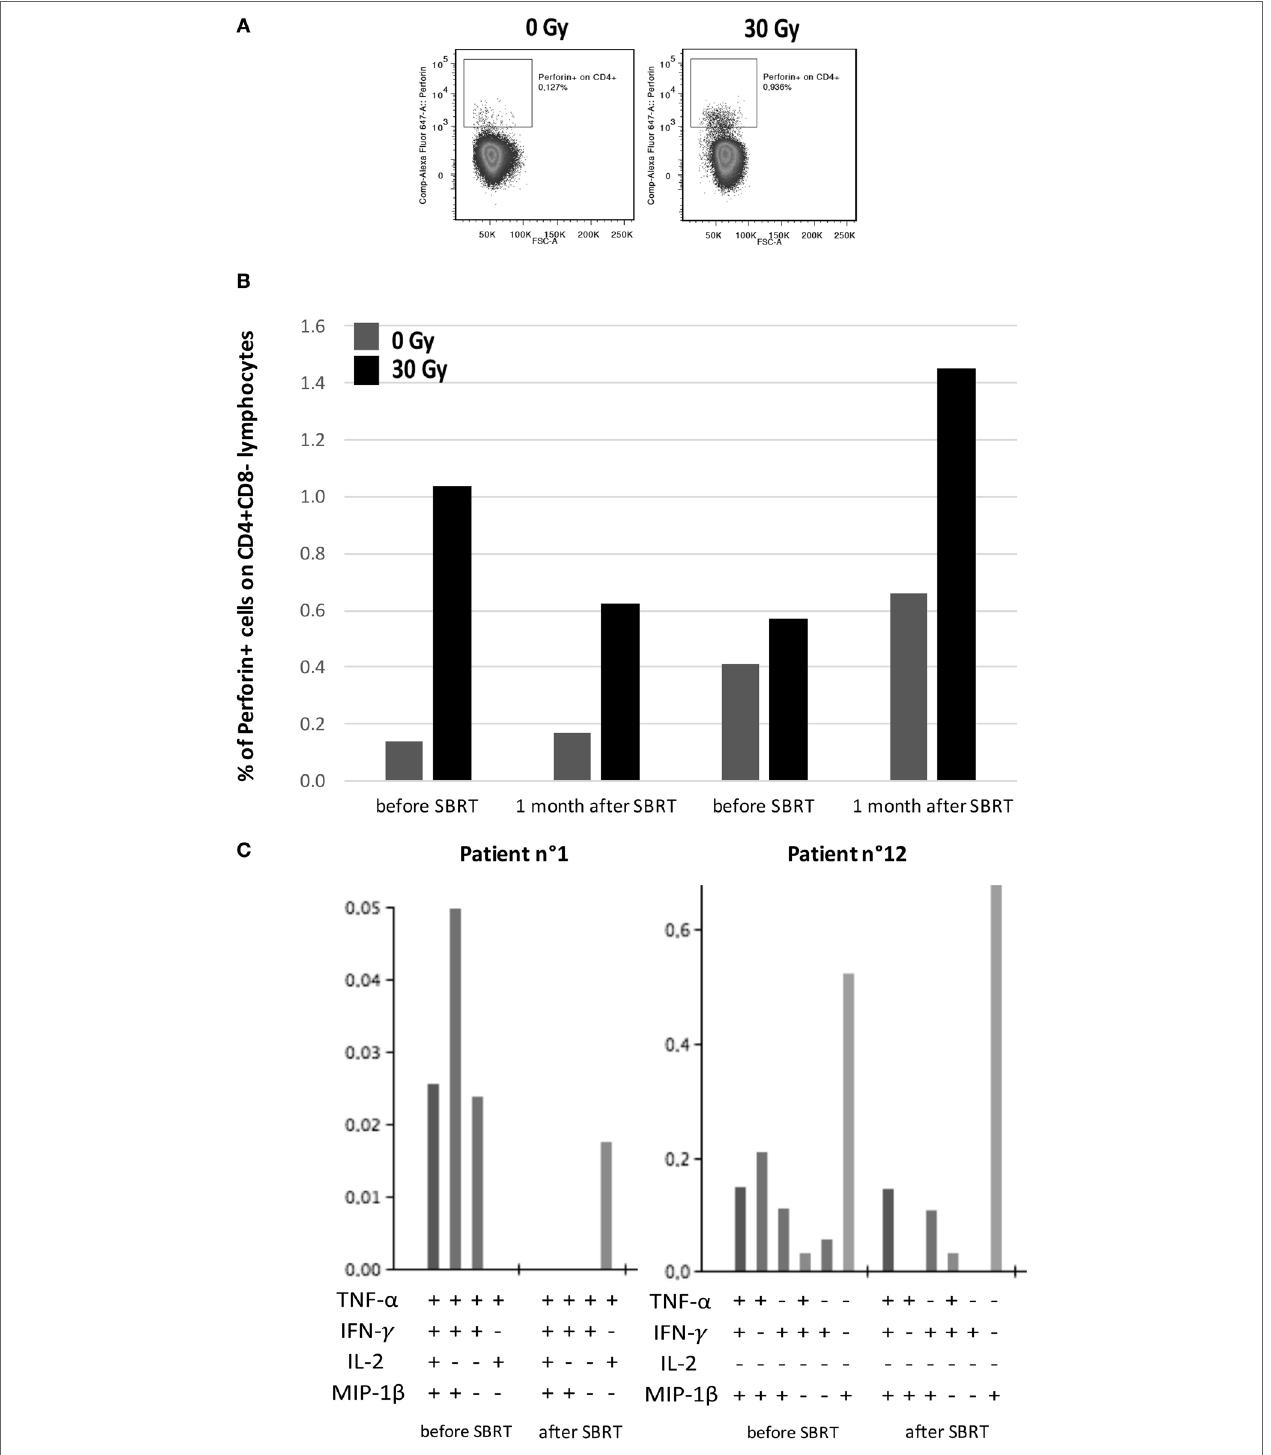
FigUre 6 | Interplay between patients’ tumor-specific T cells and irradiated breast cancer in vitro model. (a) Representative flow cytometry dot plots showing perforin + /CD4 + lymphocytes in intracellular staining after 12 h of co-culture with MDA-MB231 untreated (left) or treated with 30 Gy (right) 72 h before. (B) Percentages of perforin + cells among CD4 + lymphocytes collected from patients no. 1 and no. 12 before SBRT or 1 month after SBRT and co-cultured with MDA-MB231 untreated (dark gray) or irradiated with 30 Gy (dark) 72 h before, at an effector:target ratio of 2:1. (c) Histogram of Boolean analysis performed in patients no. 1 and no. 12 and showing polyfunctional T cells after stimulation with MHC class-II-restricted survivin-derived peptides, before and after SBRT. Each bar represents a population of T cells producing a distinct set of cytokines as reported below.